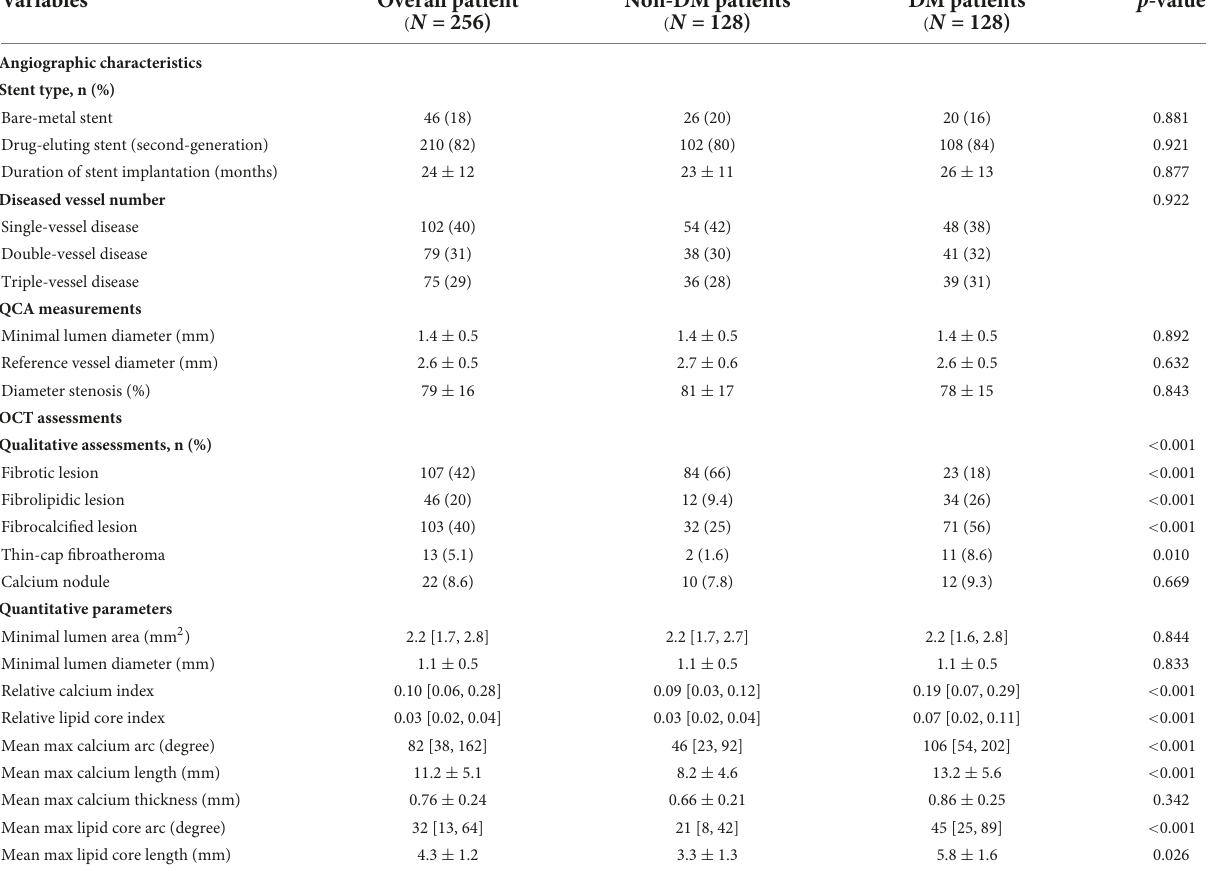
TABLE 2 Angiographic characteristics and OCT assessments of enrolled patients stratified by DM. Variables Overall patient